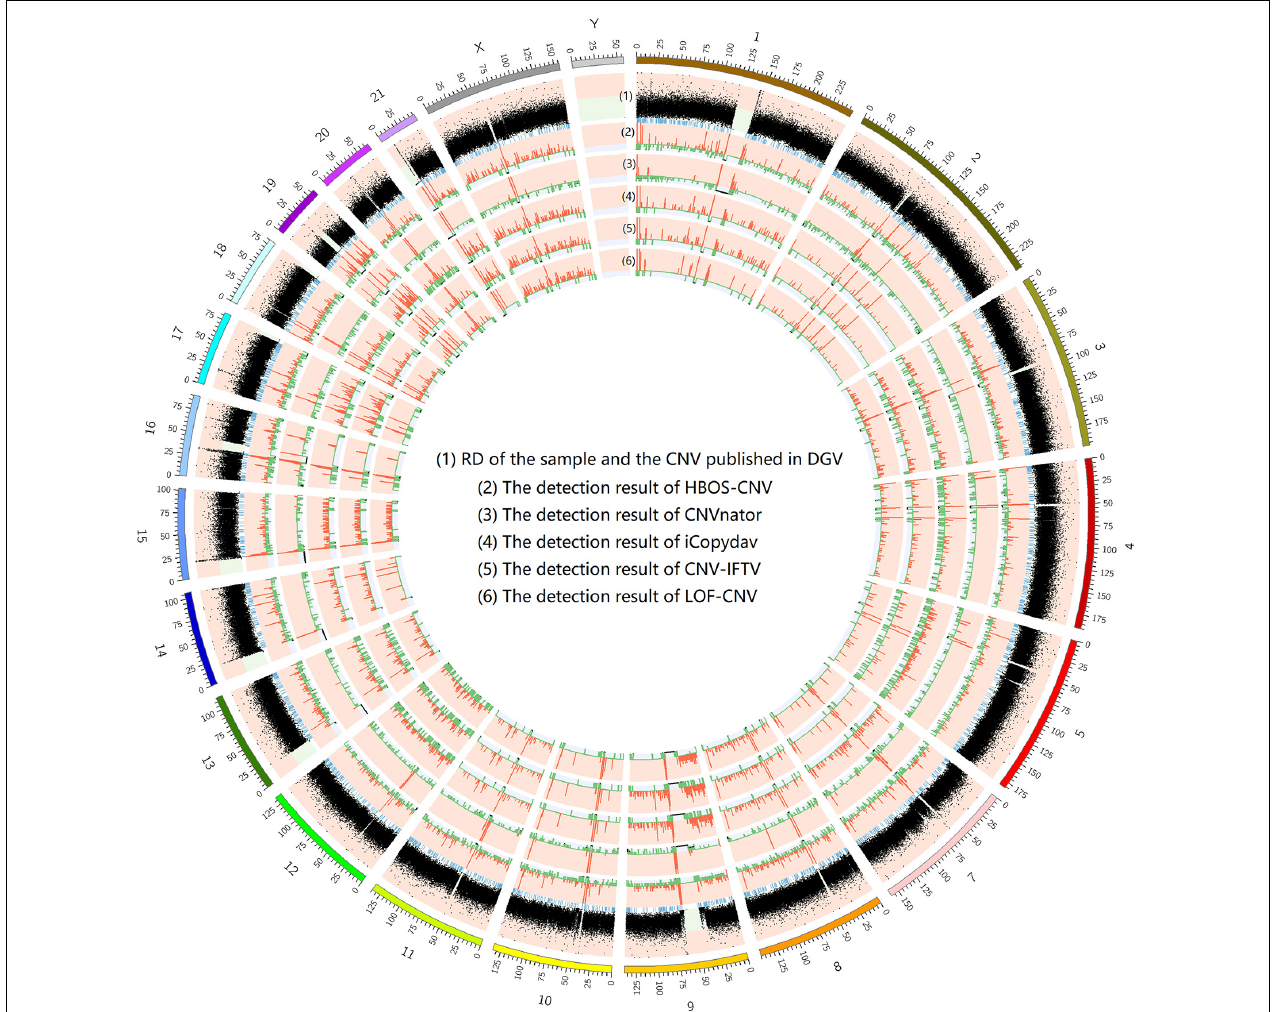
FIGURE 9 | The detection of all whole genomes of NA19240 is shown, with the circles representing (1) RD, and CNV published in DGV (2) the CNVs detected with HBOS-CNV, (3) the CNVs detected with CNVnator, (4) the CNVs detected with iCopyDav, and (5) the CNVs detected with CNV-IFTV, (6) the CNVs detected with LOF-CNV, from the outside to the inside.